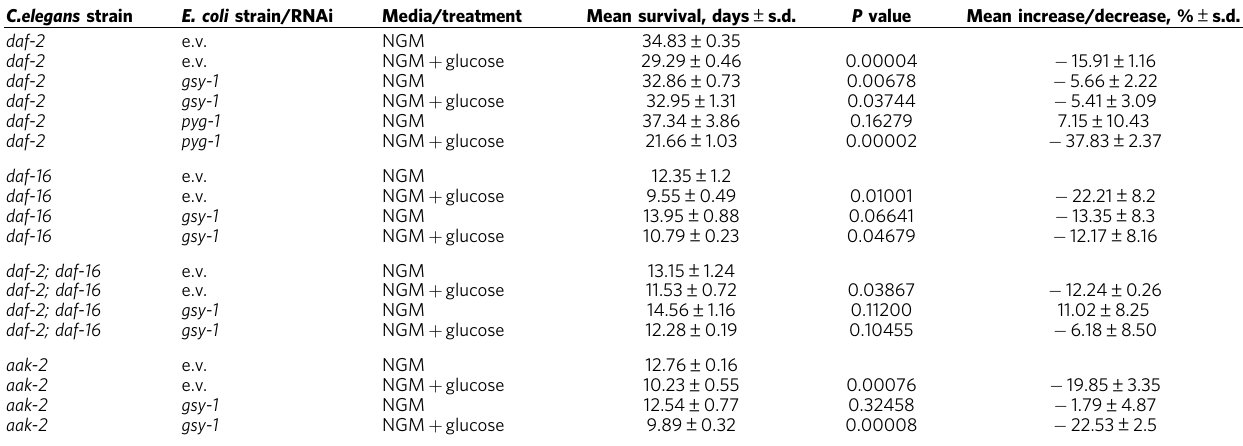
Table 2 | Summary of lifespan experiments with mutant C. elegans strains.